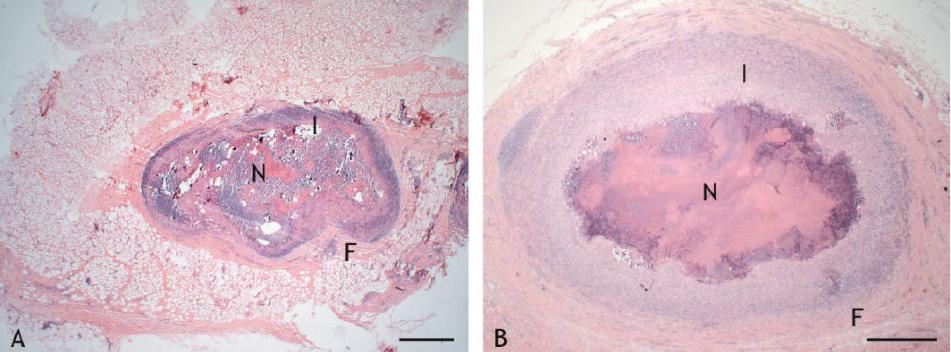
Figure 3. Granulomas with central necrosis (N) surrounded by an inflammatory infiltrate (I) of variable width and enclosed by a fibrous connective tissue capsule (F). ( A ). BCG-induced granuloma, goat 15: thin inflammatory infiltrate and thin connective tissue capsule. ( B ). VPM1002-induced granuloma, goat 1: wide inflammatory infiltrate and wide connective tissue capsule. Hemalaun-eosin (HE) stain. Scale bars = 100 µm.